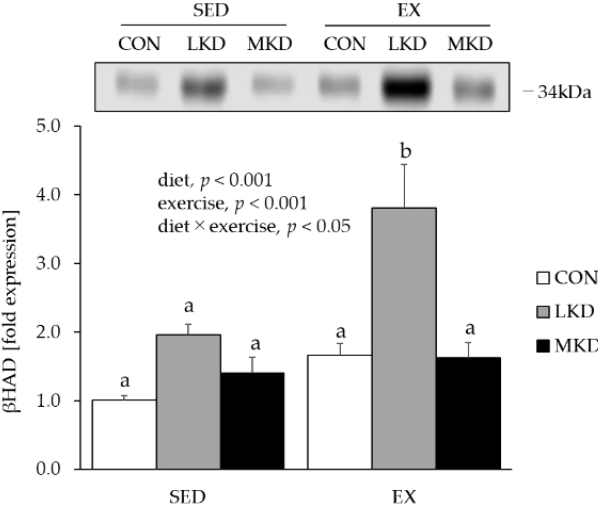
Figure 4. Protein expression of βHAD in epitrochlearis muscle tissue. Two-way ANOVA was performed, followed by a Tukey–Kramer multiple-comparison test. Means of treatments labeled with the same letter are not significantly different from each other. Values are means ± SEM, n = 7. A representative western immunoblot image is shown.